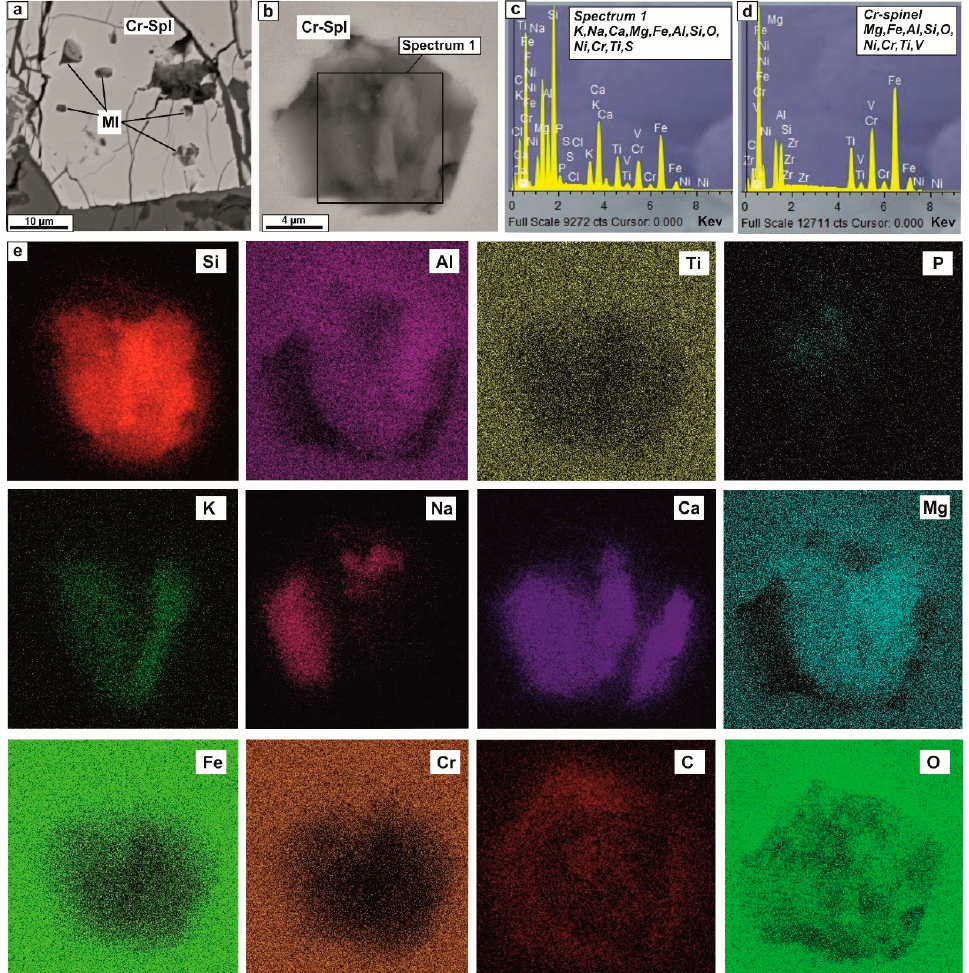
Figure 11 . Melt inclusions in the Cr-spinel crystal from the aillikites of the Terina complex: ( a ) BSE photo of the locations of the inclusions; ( b ) BSE-photo of the opened melt inclusion; the SEM spectra of the inclusion ( c ) and Cr-spinel matrix ( d ) compositions; and, ( e ) the EMP X-ray element maps show the chemical composition of the opened melt inclusion.